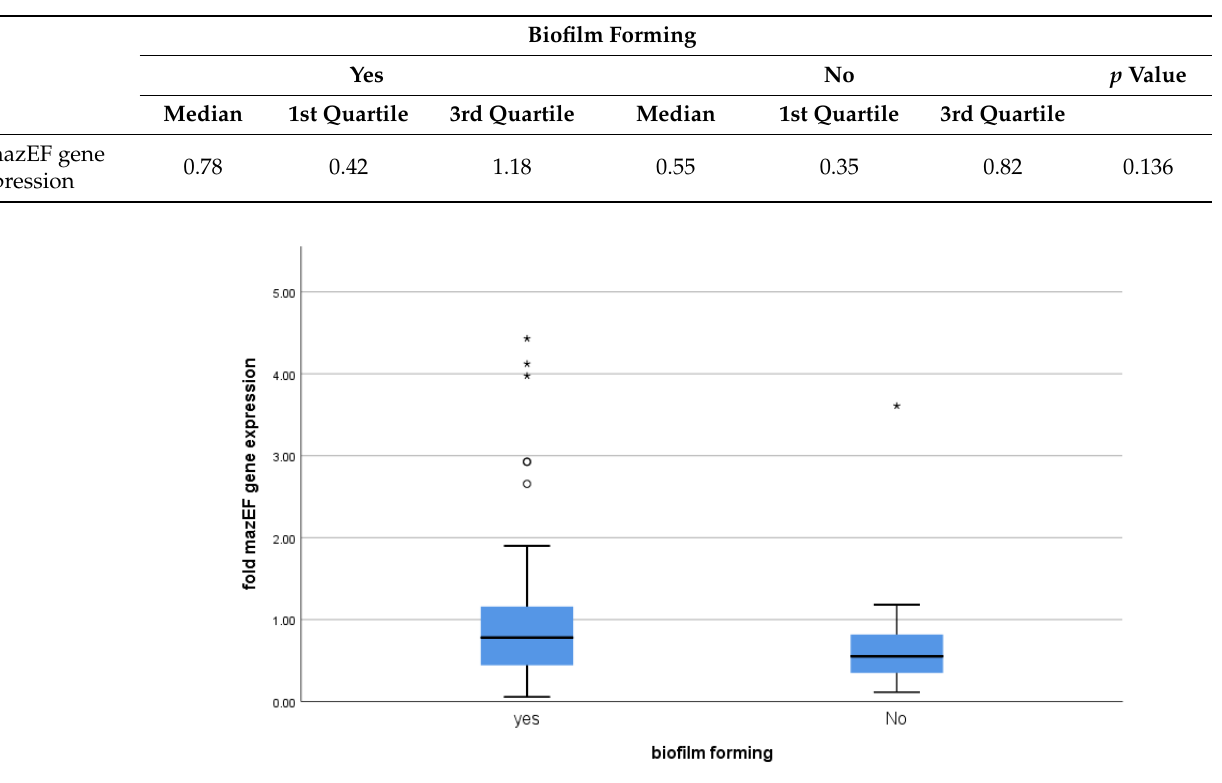
Figure 3. The mazEF expression in relation to methicillin susceptibility. On the boxplot, circles ° represent outliers and stars * represent more extreme values.